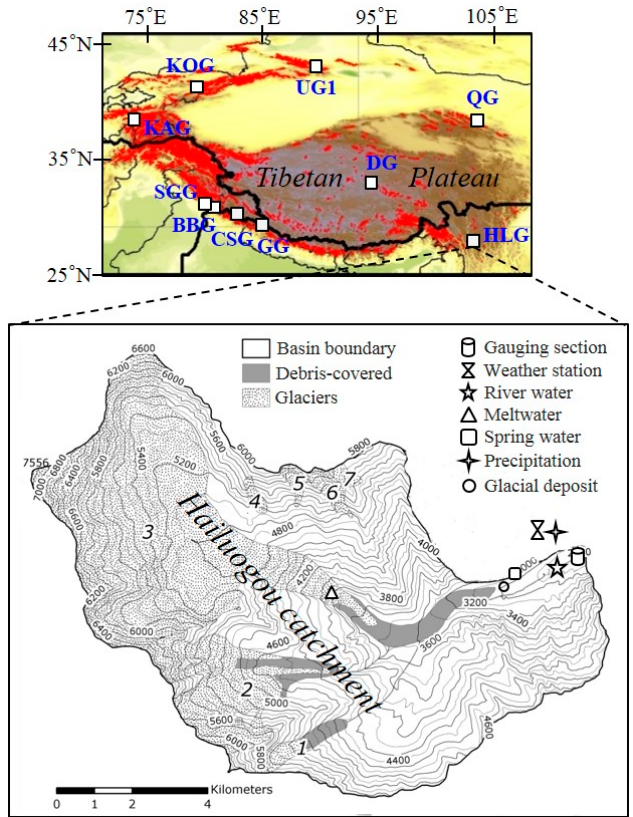
Figure 1. Location map showing the sampling sites, weather station and gauging section at the Hailuogou basin (HLG) in the southeastern Tibetan Plateau, as well as at Kartamak Glacier (KAG) in the Muztag Ata Mountains, at Koxkar Glacier (KOG) and Urumqi Glacier No.1 (UG1) in the Tianshan Mountains, at Shaune Garang Glacier (SGG), Bilare Banga Glacier (BBG), Chhota Shigri Glacier (CSG) and Gangotri Glacier (GG) in the Himalaya Mountains, at Dongkemadi Glacier (DG) in the Tanggula Mountains, and at Qiyi Glacier (QG) in the Qilian Mountains in Asia.